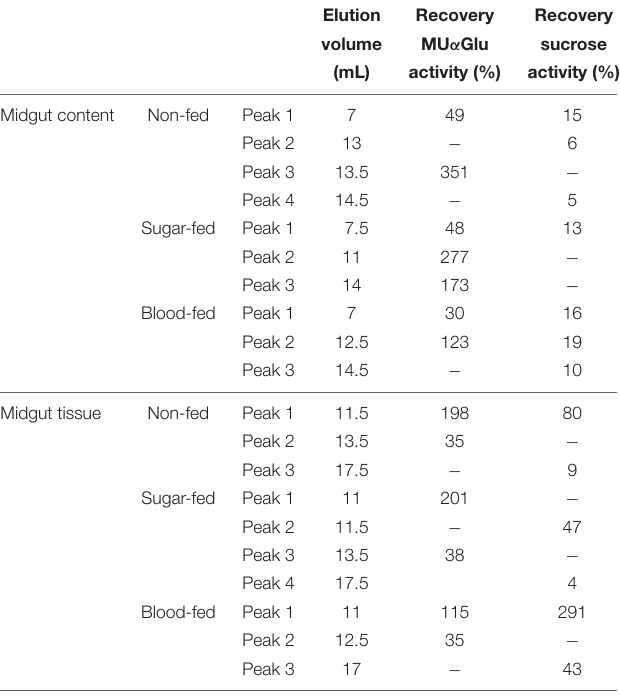
TABLE 4 | Recovery of activity from peaks obtained after Gel filtration chromatographies (Superdex 200 column, AKTA-FPLC) of the midgut contents or midgut tissue samples of L. longipalpis